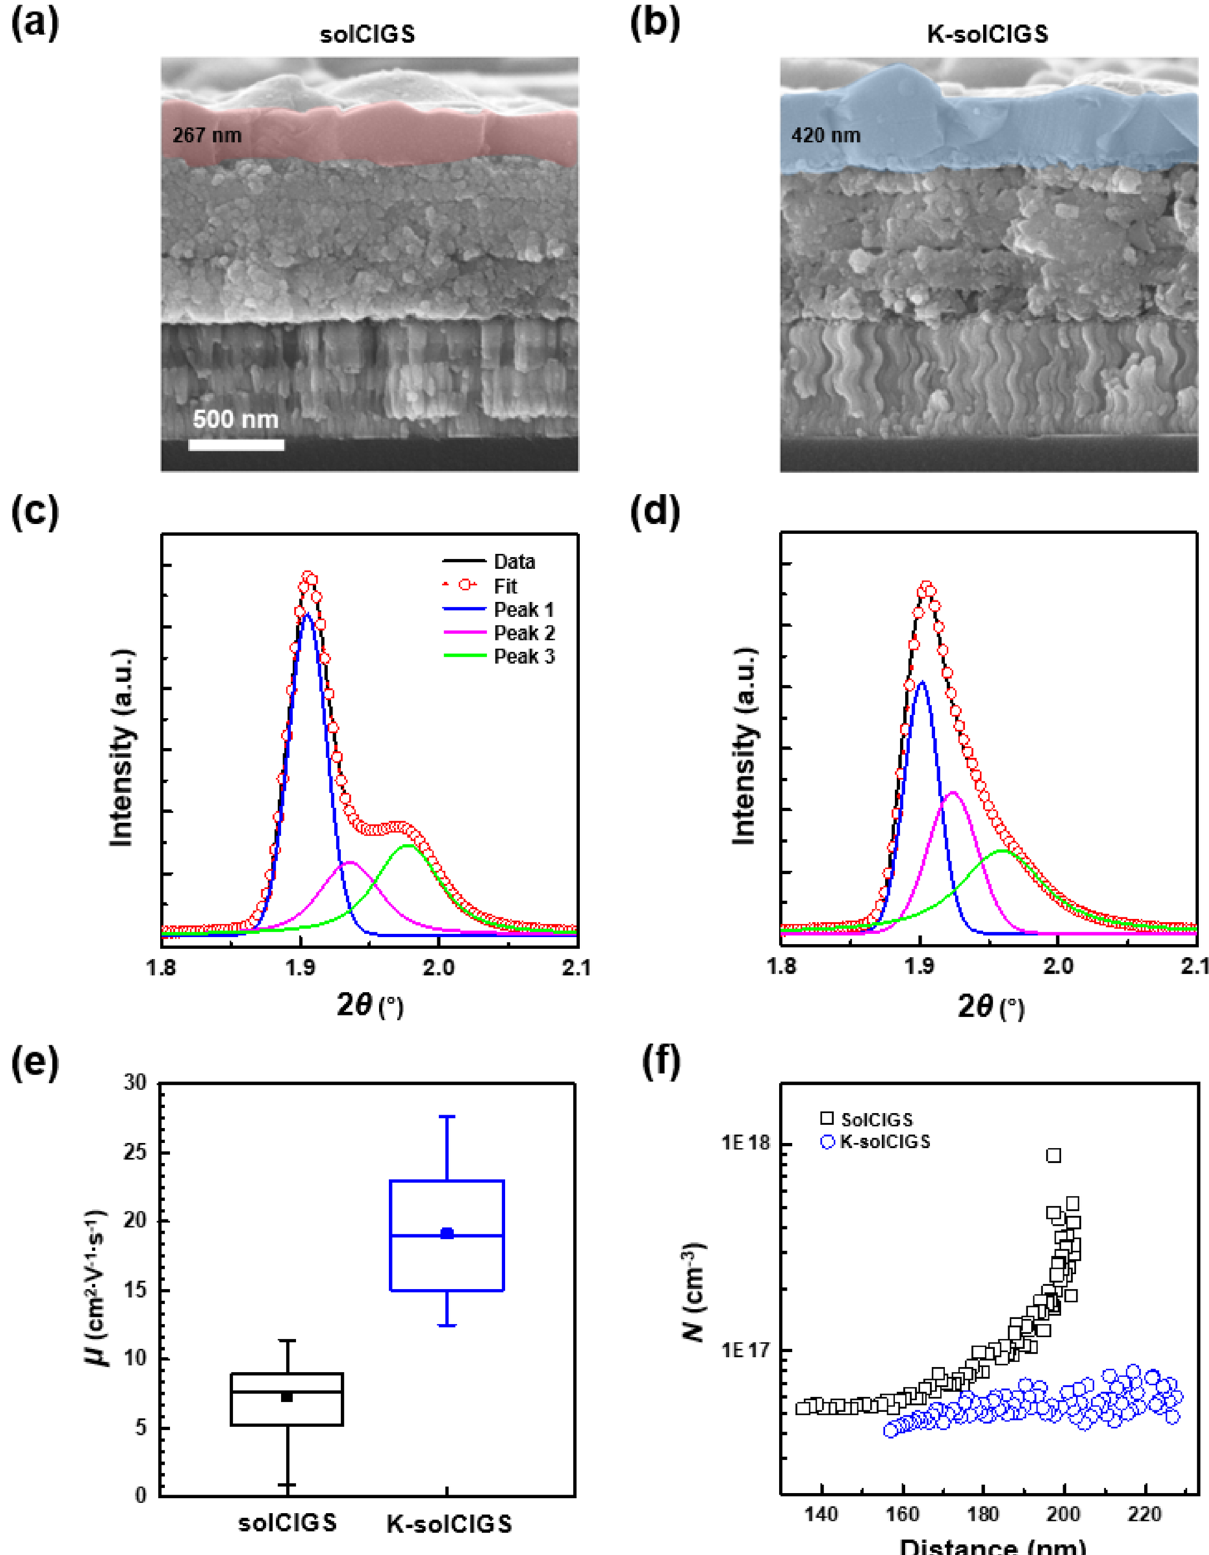
Figure 2. ( a , b ) Cross-sectional SEM images of ( a ) solCIGS and ( b ) K-solCIGS thin films. Colored areas denote upper layer regions. ( c , d ) Circular averaged 1D GI-WAXS profiles of ( c ) solCIGS and ( d ) K-solCIGS thin films. ( e ) Box plots, showing variation range of Hall mobility ( μ ) of solCIGS and K-solCIGS devices. ( f ) Spatial distributions of the charge carrier density, estimated by C ‒ V measurement of solCIGS and K-solCIGS devices; modified with permission from ref 14, Copyright 2020,